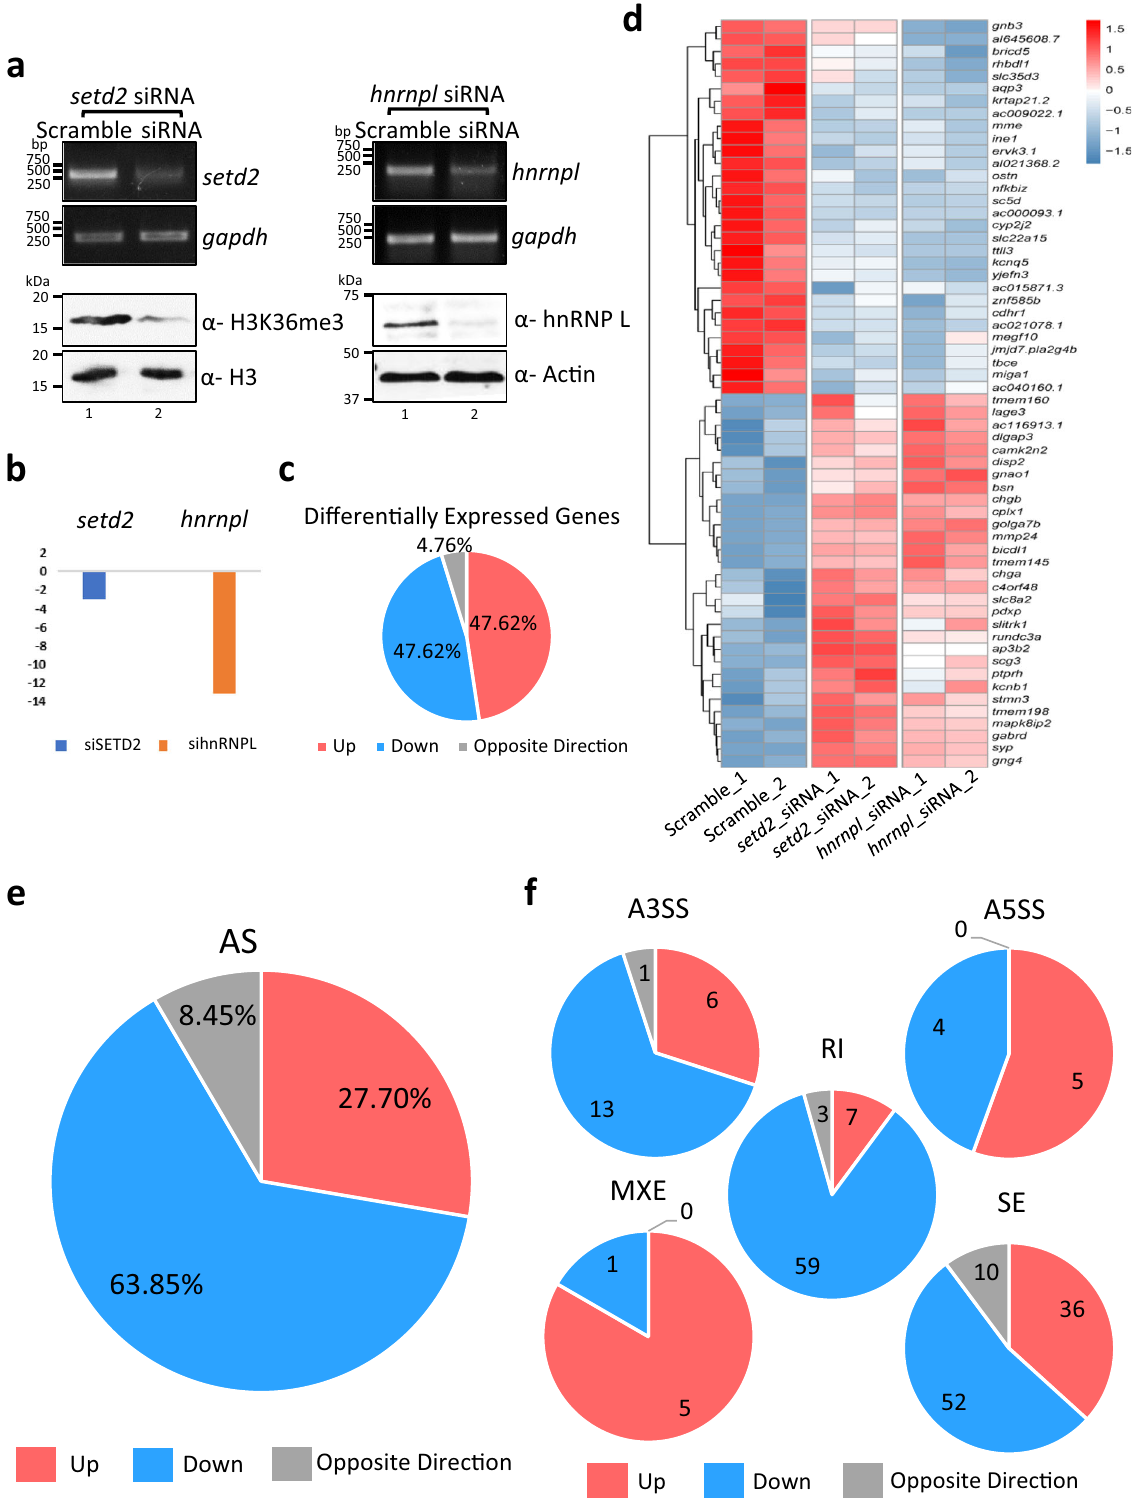
Fig. 6 SETD2 and hnRNP L depletion affect transcription and splicing of a common subset of genes. a RNA was isolated from 293T cells transfected with siRNA and RTPCR was performed to check transcript levels. gapdh was used as a normalization control. Western blot of whole-cell lysates was performed with the depicted antibodies. The experiment was repeated at least seven times all yielding similar results. b Chart showing the decrease in expression of the genes depicted based on RNA-seq analysis post siRNA treatment. c , e , f Pie charts showing the fractions of differentially expressed genes and AS events that occur in both setd2 and hnrnpl depletion. d Heat map showing the genes that show differential expression in both setd2 and hnrnpl depleted 293T cells. AS alternative splicing, A3SS alternate 3 ′ splice site, A5SS alternate 5 ′ splice site, RI retained intron, MXE mutually exclusive exon, SE skipped